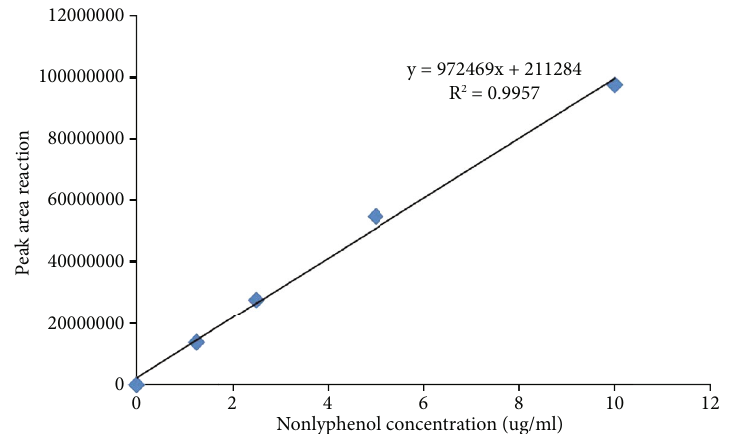
Figure 4: Calibration chart. The ratio of the area under the curve to the concentration of NP R 2 = 0/9957